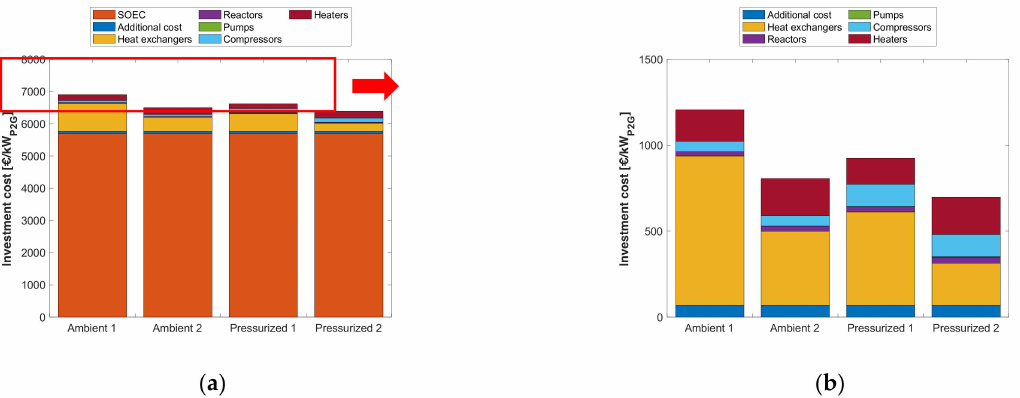
Figure 7. Investment cost contributions of the investigated P2G configurations in the reference techno- economic scenario (ratio between the P2G power size and the renewable generation peak power equal to 1/1.7; SOEC specific investment cost equal to 5700 EUR/kW; no carbon tax application): ( a ) total plant cost; ( b ) detail of all the components cost excluding the SOEC.